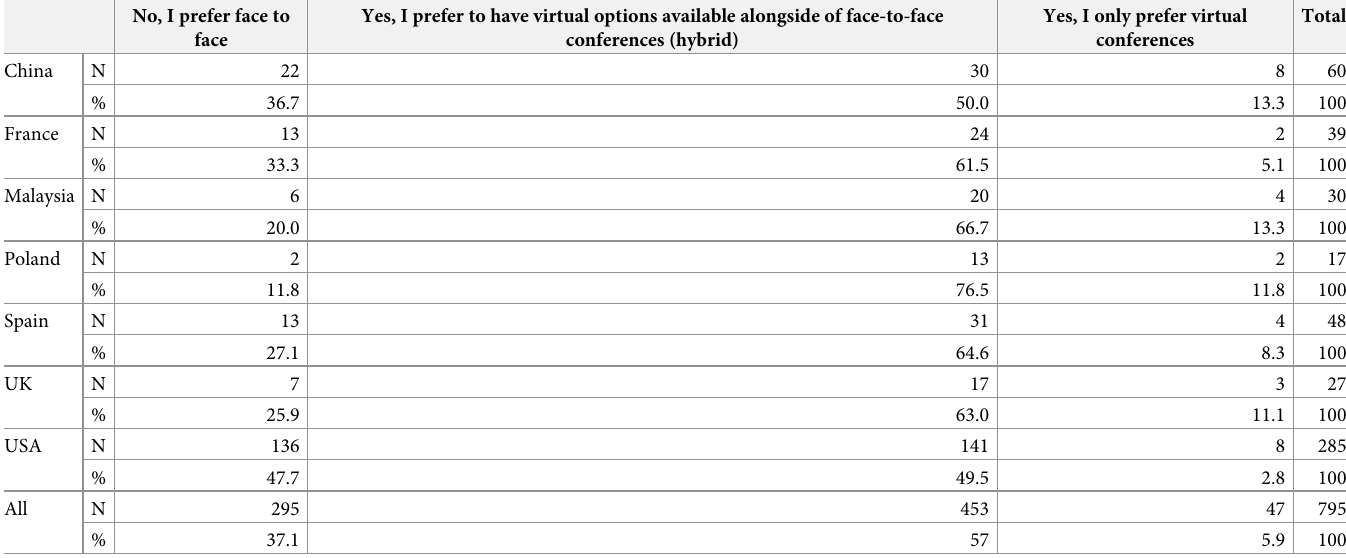
Table 15. Would you prefer virtual conferences to continue post-pandemic?